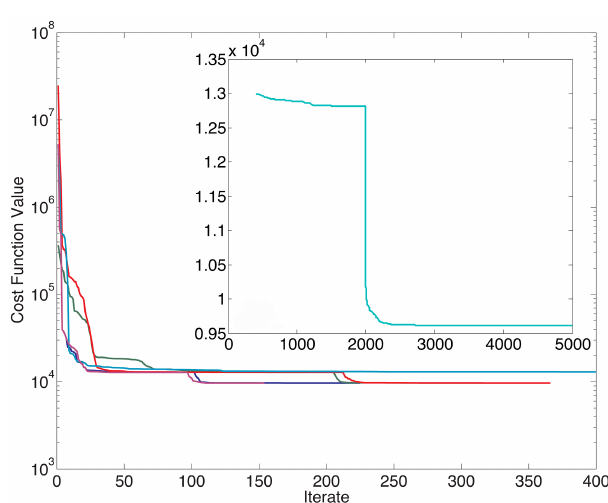
Figure 2. Cost function value for all five experiments in log scale for the first 400 iterations and cost function value for constrained optimisation from 400 to 5000 in linear scale (dark blue: Gaussian, green: log, red: quadratic, light blue: constrained, pink: